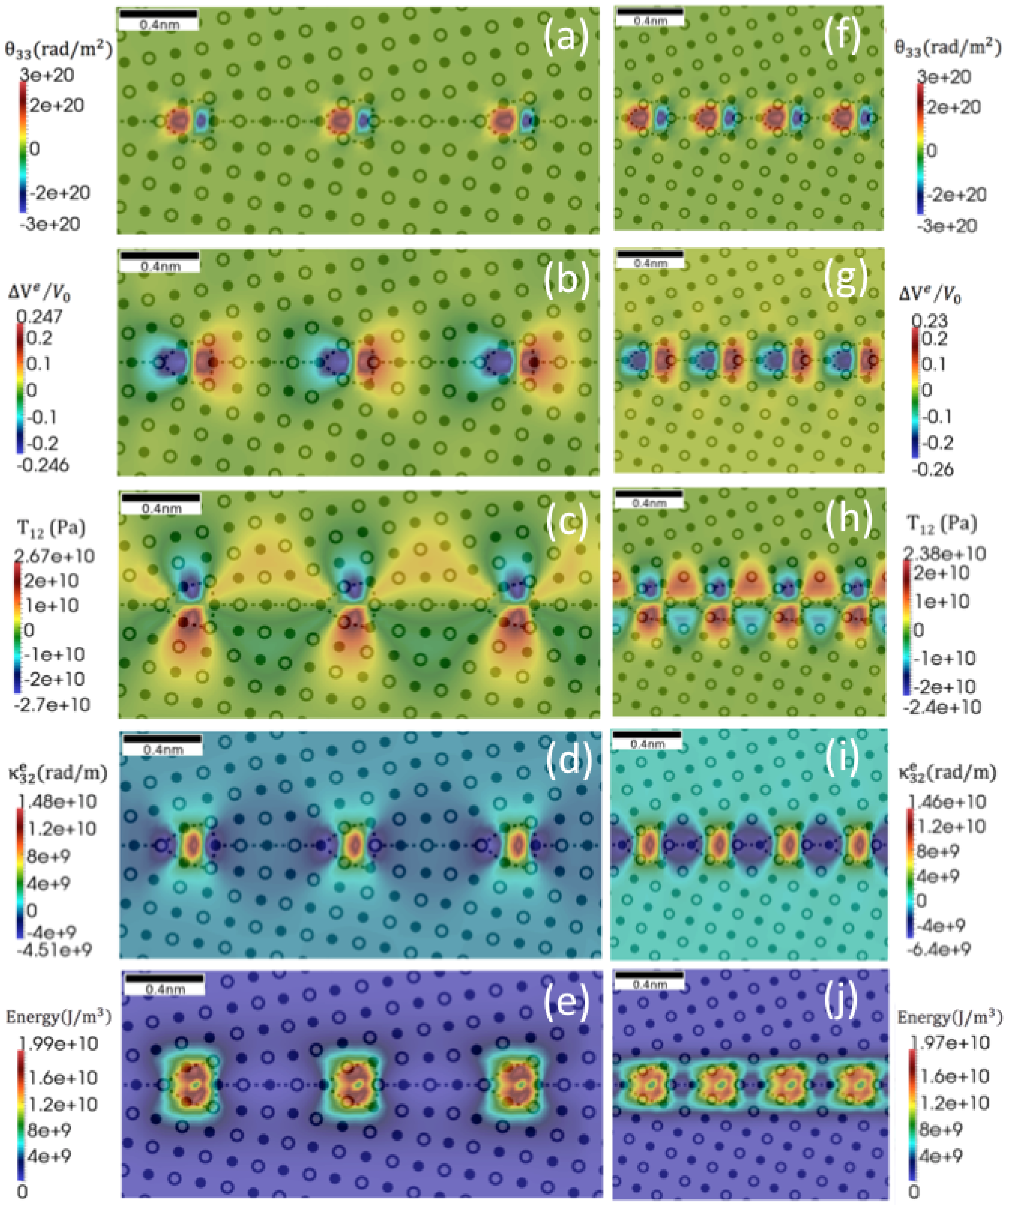
Figure 2. Disclination model for a ∑ 37(610) symmetrical < 001 > tilt boundary of misorientation 18.9 ◦ ( left column ) and of a ∑ 5(310) symmetrical < 001 > tilt boundary of misorientation 36.9 ◦ ( right column ). The wedge-disclination density θ 33 (rad/m 2 ) is shown on top of the relaxed atomic structure ( a , f ); Elastic dilatations/contractions ( b , g ); Shear stress field T 12 (Pa) ( c , h ); Elastic curvature κ 32 (rad/m) ( d , i ); Elastic energy density (J/m 3 ) ( e , j ). Atomic structures are taken from reference